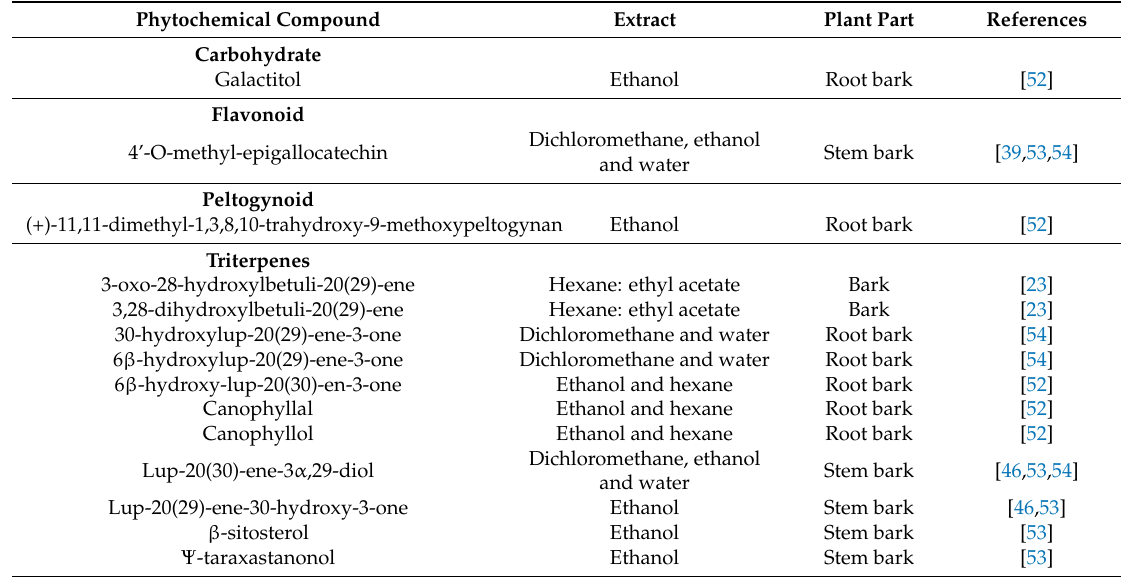
Table 3. Phytochemical composition of Elaeodendron transvaalense